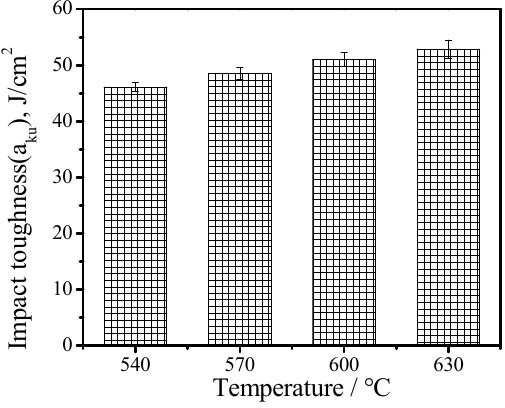
Figure 9. Impact toughness of Ti17 alloy with test at room temperature.